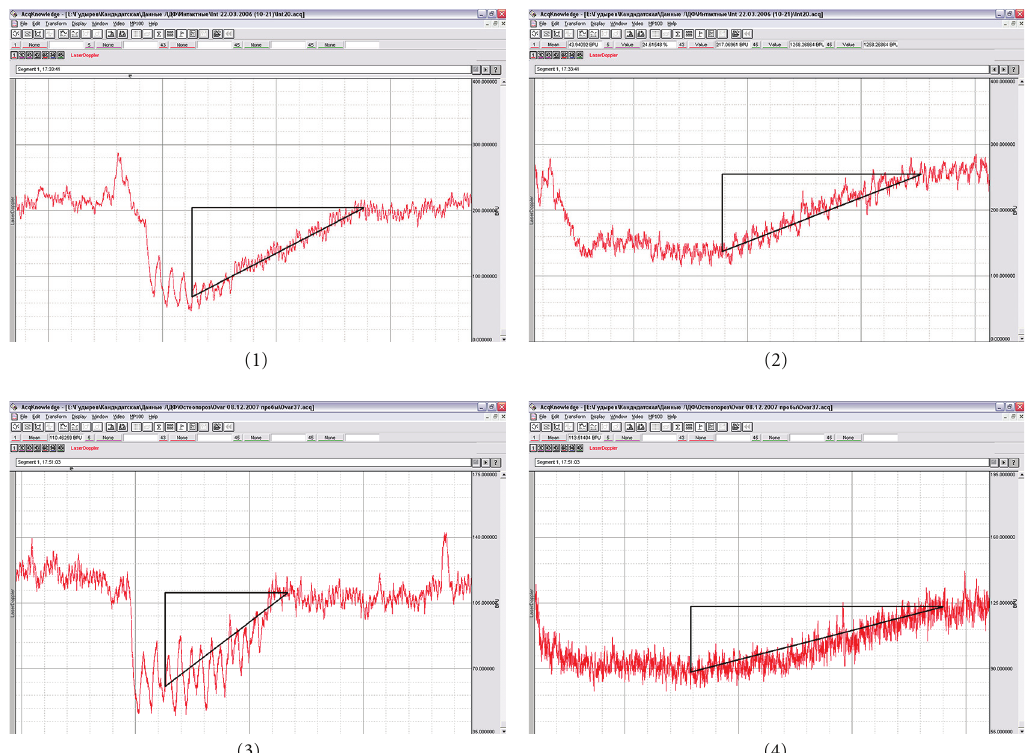
F 1: Examples of dynamics of the level of microcirculation in bone during functional vascular tests. (1) EDVD response in intact rats; (2) ENVD reaction in intact rats; (3) EDVD reaction in rats aer bilateral ovariectomy; (4) ENVD reaction in rats aer bilateral